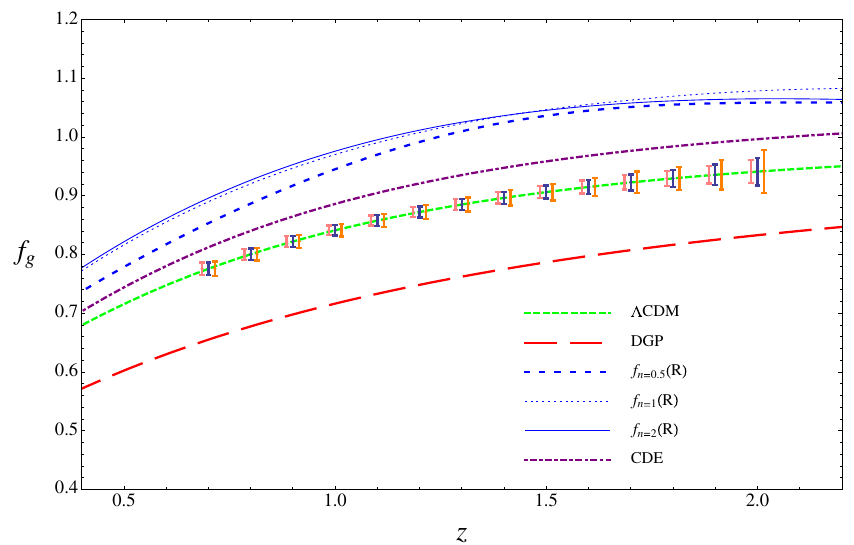
Fig. 18 Expected constraints on the growth rates in each redshift bin. For each z the central error bars refer to the Reference case while those referring to the Optimistic and Pessimistic case have been shifted by − 0 . 015 and + 0 . 015 respectively. The growth rates for different models are also plotted: Λ CDM (green tight shortdashed curve), flat DGP (red longdashed curve) and a model with coupling between dark energy and dark matter (purple, dot-dashed curve). The blue curves (shortdashed, dotted and solid) represent the f ( R ) model by Hu and Sawicki (2007a), Eq. (I.5.36) with n = 0 . 5 , 1 , 2 respectively and μ = 3. The